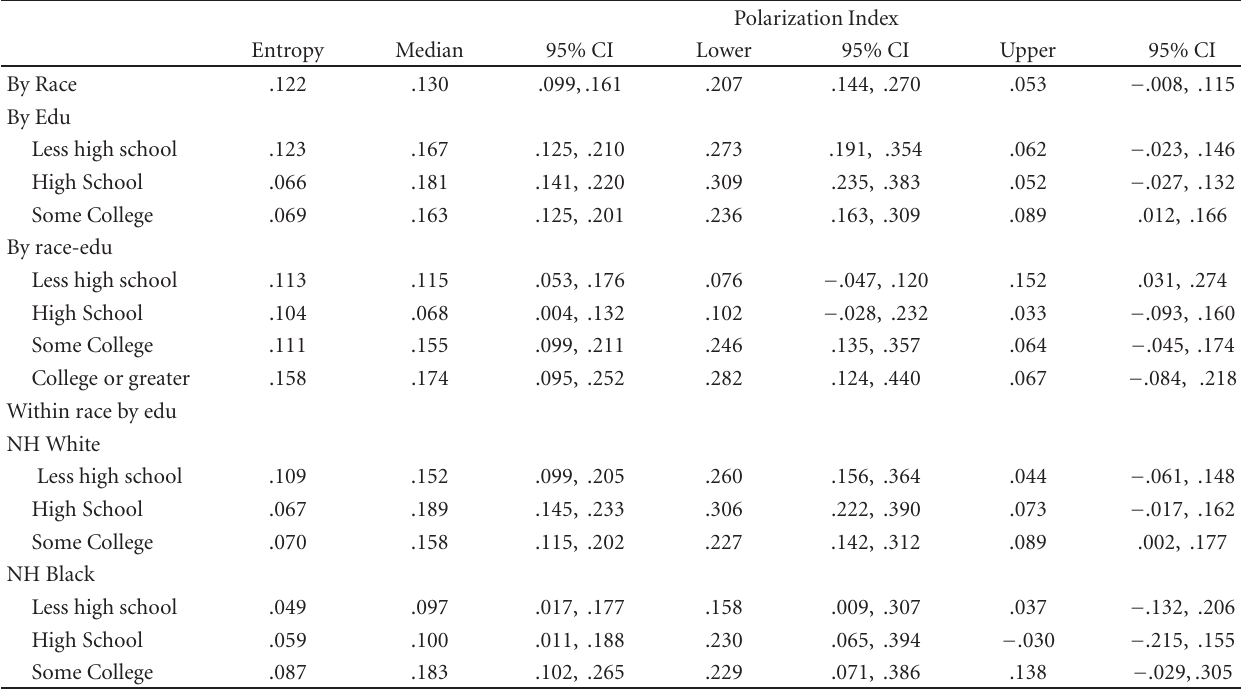
Table 3: Summary measures for distributional comparisons for women, by race, education, and race-education subgroups, United States (1999–2006).